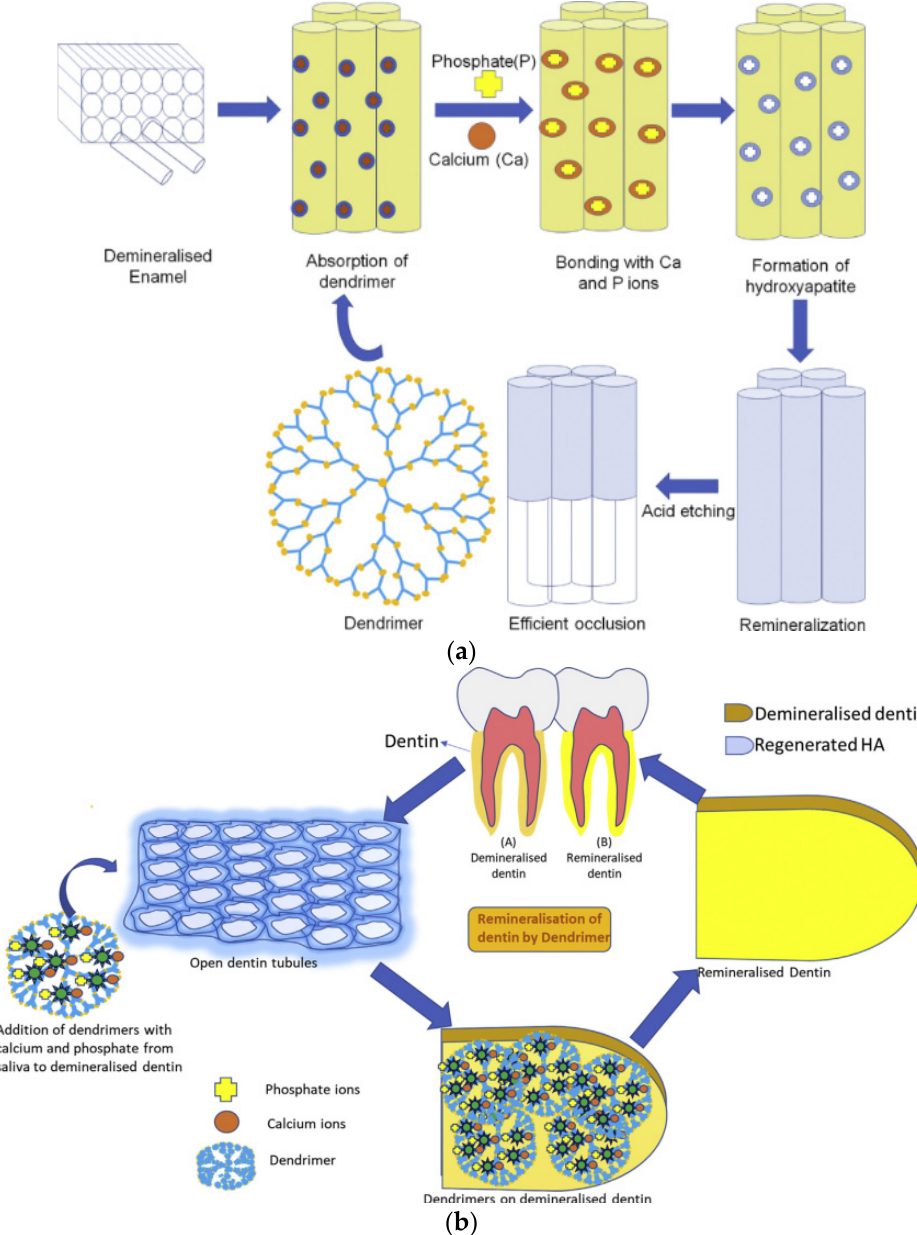
Figure 20. ( a ) Remineralization of demineralized enamel by dendrimers. ( b ) Remineralization of demineralized dentin by dendrimers. Both were reproduced under permission from [209]. Copyright: Elsevier Ltd.